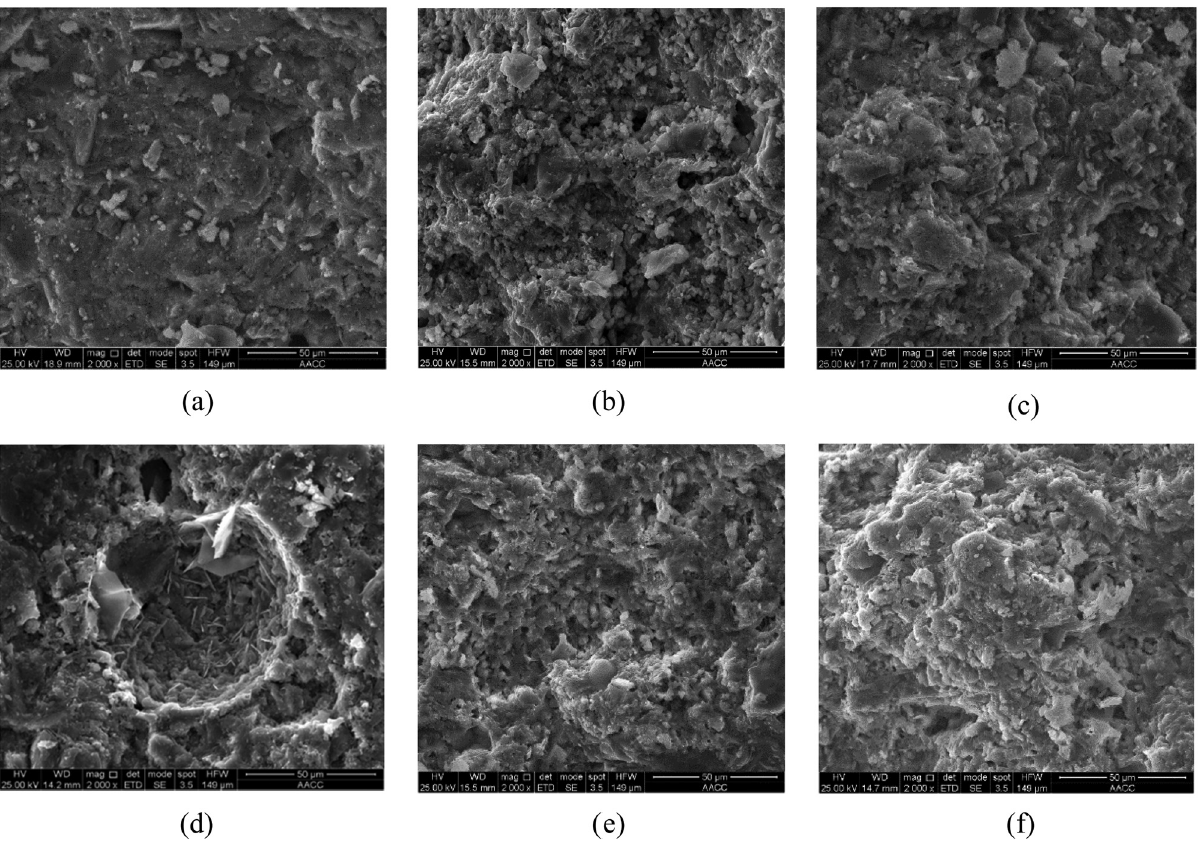
Figure 6: SEM images of cement paste samples at di ff erent ages ( a ) SC0 ( 28 d ) ( b ) AC0 ( 28 d ) ( c ) ACNC ( 28 d ) ( d ) SC0 ( 300 d ) ( e ) AC0 ( 300 d ) ( f ) ACNC ( 300 d )